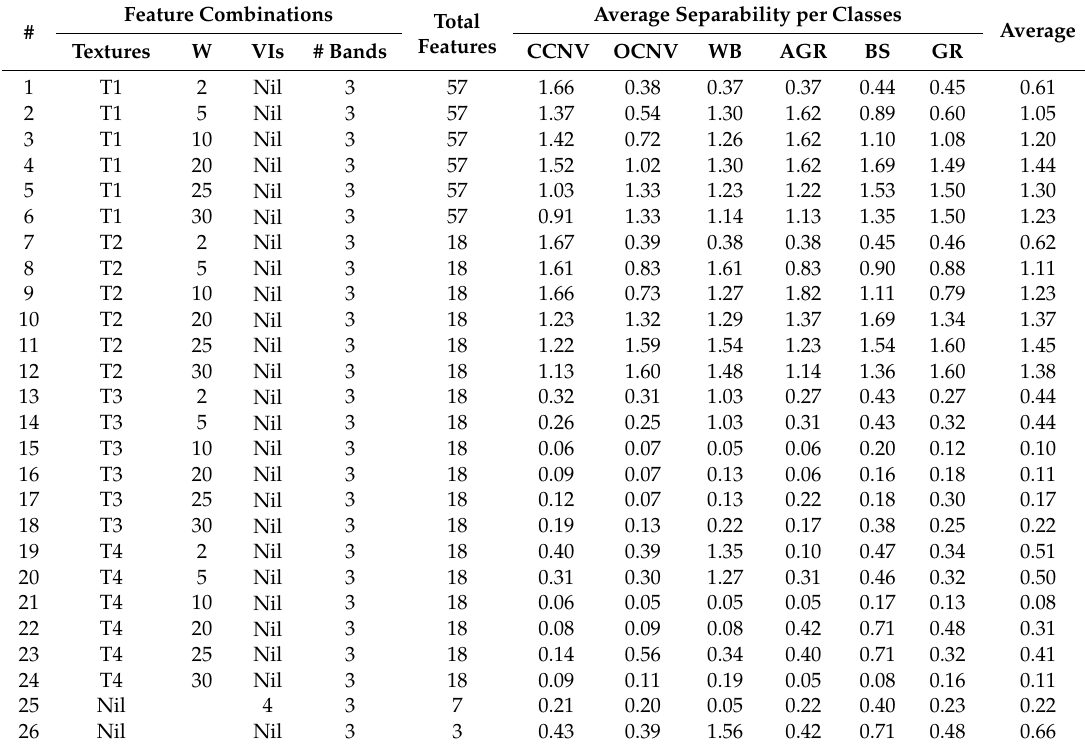
Table 4. Feature combinations as tested and average separability per class of land cover type, per feature combination, and average separability per feature